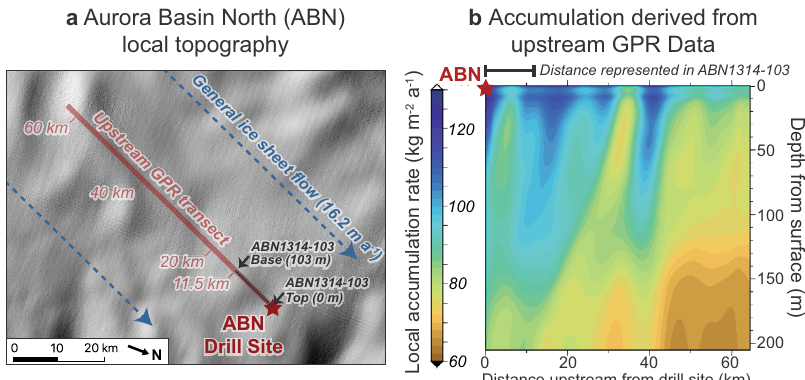
Fig. 5 Topography and accumulation patterns upstream of the Aurora Basin North (ABN) drill site. a Local surface topography of the ice sheet around the ABN ice core drilling site, shown as a hillshade derived from the REMA digital elevation model 11 with 100x vertical exaggeration. Ground-penetrating radar measurements were taken along a 60 km transect upstream of the drill site relative to local ice sheet fl ow, and the ice contained in the ABN1314-103 core corresponds to the fi rst 11.5 km of the transect. b Local accumulation rate variability with depth along the upstream ABN transect determined from radar identi fi cation of isochronal internal re fl ective horizons, re fl ecting past changes in surface mass balance. Regions of relatively higher or lower accumulation preserved with depth likely represent the in fl uence of long-lived surface topographic features. Accumulation rates have an original depth resolution of 0.5 m which is smoothed through a moving age-depth average with a cosine weighting window to reduce isochron artifacts 49